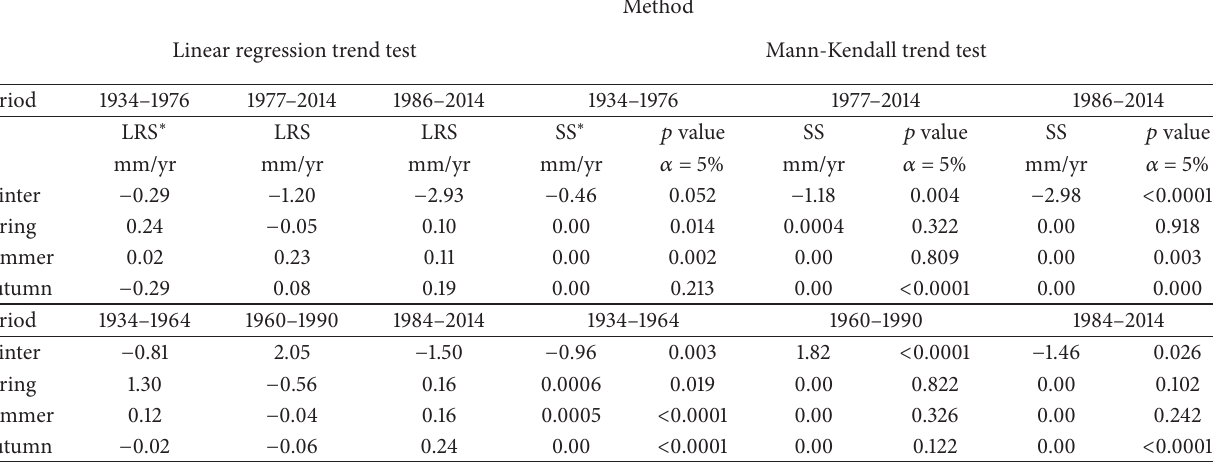
Table 4: Short-term and long-term seasonal trend analysis by linear regression and Mann-Kendell tests(one-tailed with 5% significance interval).